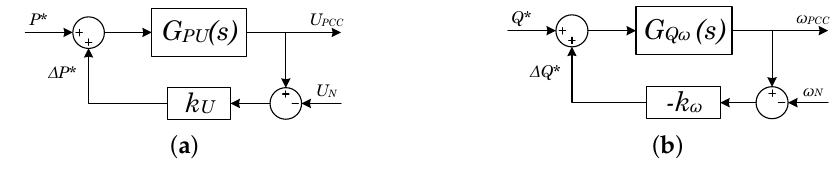
Figure 6. AI-PF methods. ( a ) Sandia voltage shift (SVS). ( b ) Sandia frequency shift